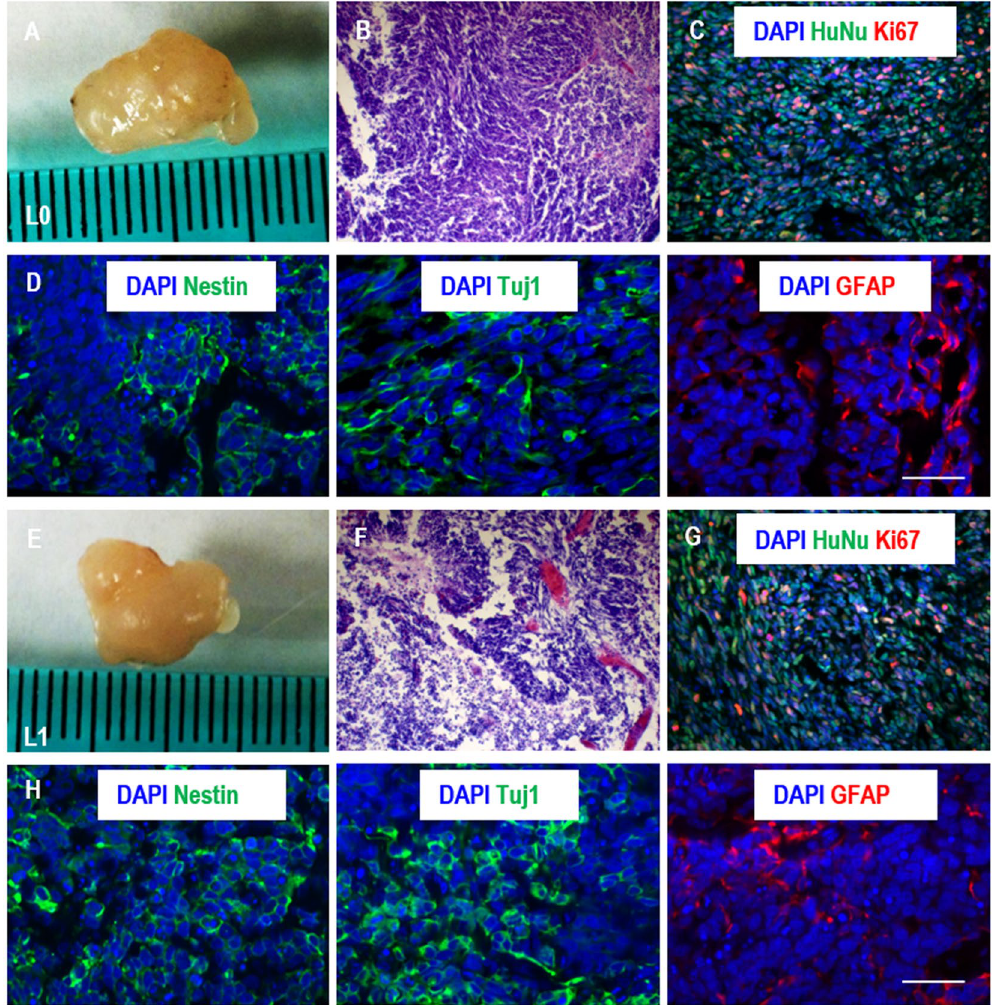
Figure 5. Xenotransplantation of glioblastoma TICs. After 10 passages in AlgTubes, TICs were transplanted subcutaneously to NOD-SCID mice. ( A , E ) Harvested tumors. ( B , F ) H&E staining of the tumor sections. ( C , G ) Large percentage of cells in the tumor tissue were human nuclear antigen (HuNu) positive human cells and were proliferating (Ki67 + ). ( D , H ) Nestin + TICs, Tuj1 + neurons and GFAP + glia cells were all found in the tumor tissue. Scale bar: 50 µ